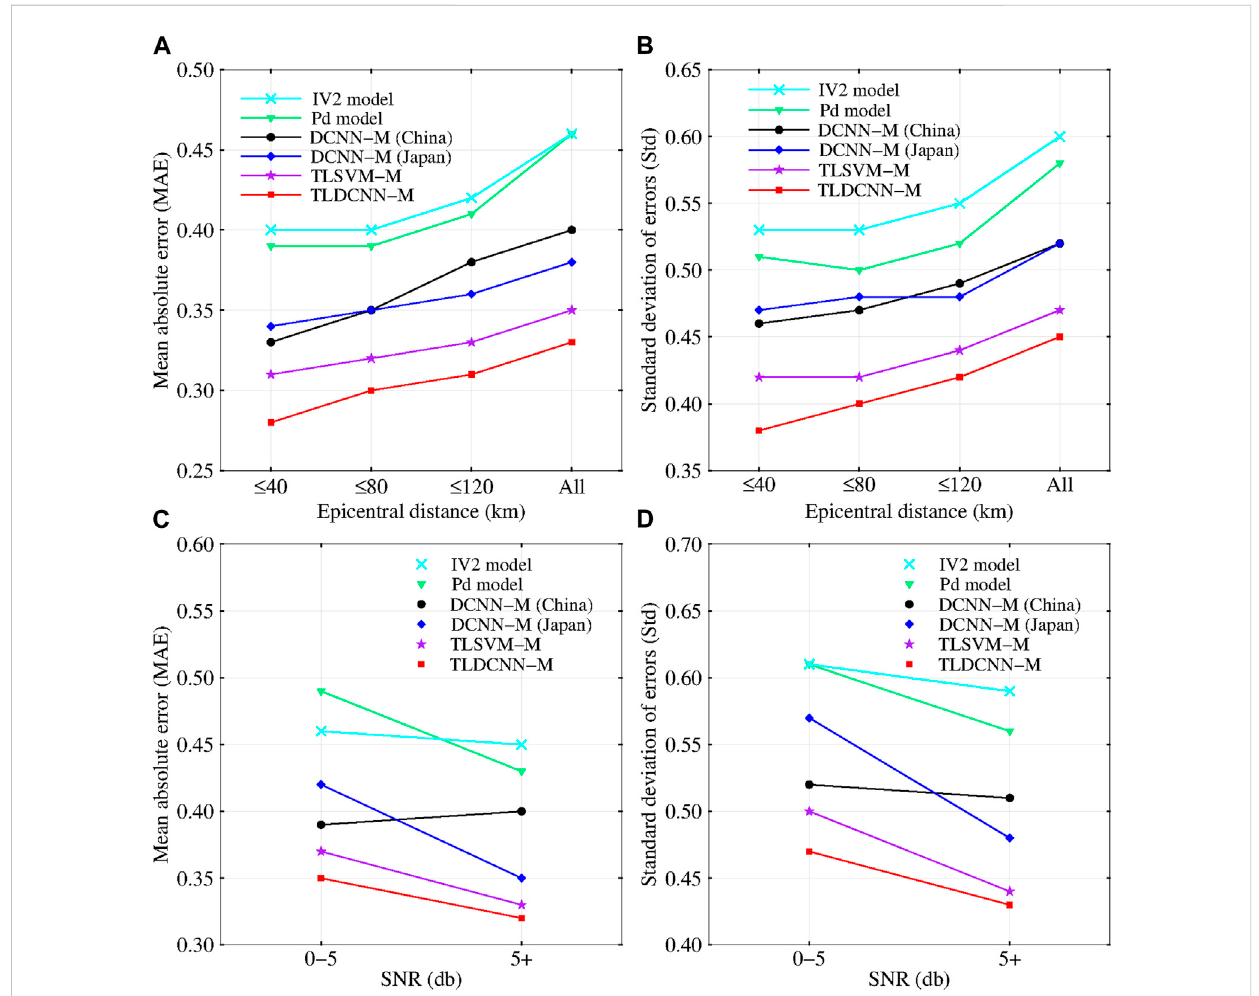
FIGURE 5 The relationship betweenthe (A) mean absolute error (MAE)and (B) standard deviation of errors (Std) and therange of different epicentral distances for the TLDCNN-M model and baseline models. The relationship between the (C) MAE and (D) Std and the range of different SNRs for the TLDCNN-M model and baseline